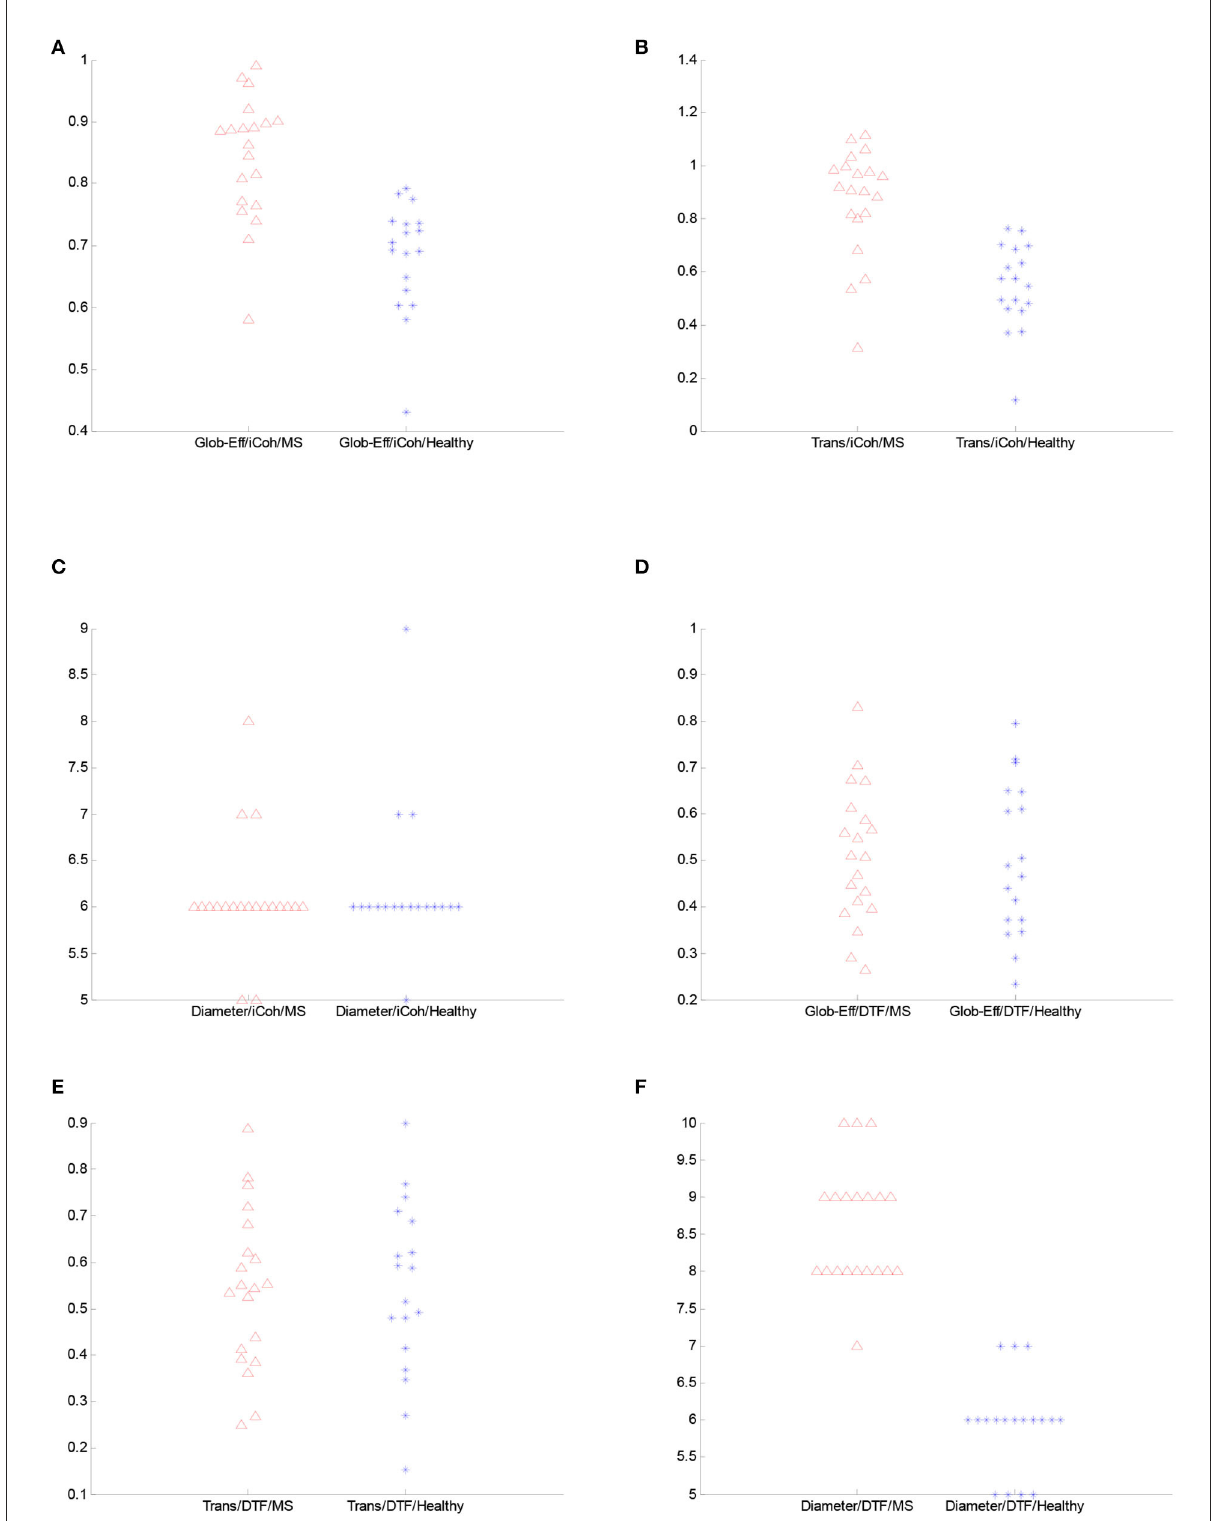
FIGURE5 The figure illustrates the comparison of the spread plot of the graph features for the complete frequency range between the groups. (A) Global efficiency from iCoh. (B) Transitivity from iCoh. (C) Diameter from iCoh. (D) Global efficiency from DTF. (E) Transitivity from DTF. (F) Diameter from